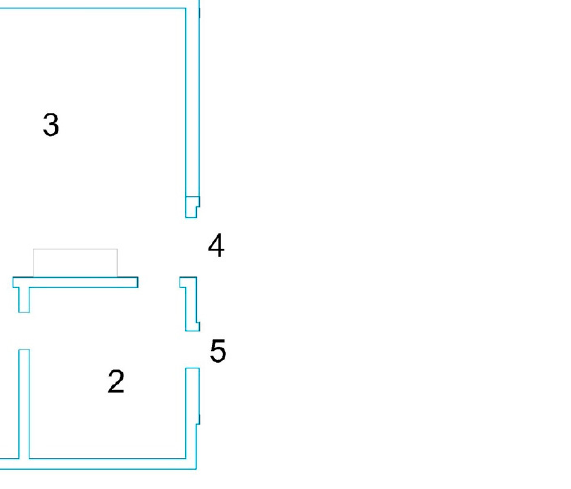
Figure 1. Layout of Architecture. The whole space was divided into three halls, namely 1, 2, and 3. There were entrances and exits between the spaces. The space exits were node 4 and node